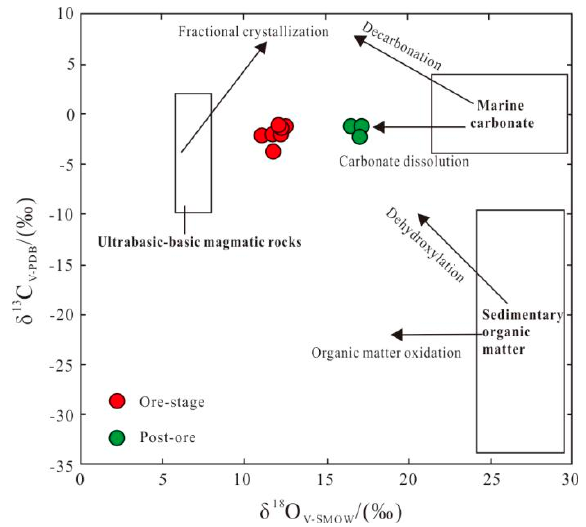
Figure 8. δ 13 C V-PDB vs. δ 18 O V-SMOW diagram of calcites from the Zhesang gold deposit [57]. Figure 8. δ 13 C δ 18 O V-PDB vs. V-SMOW diagram of calcites from the Zhesang gold deposit